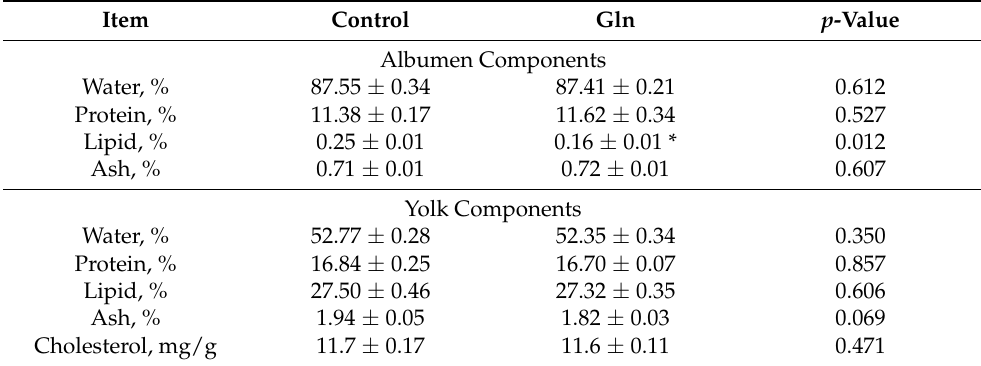
Table 3. The effect of dietary L-glutamine (Gln) supplementation (1.0%) on the composition of the albumin and yolk of eggs from laying Bovans Brown hens at the end of a 30-week-long supplementa- tion period (31st–60th wks of age).